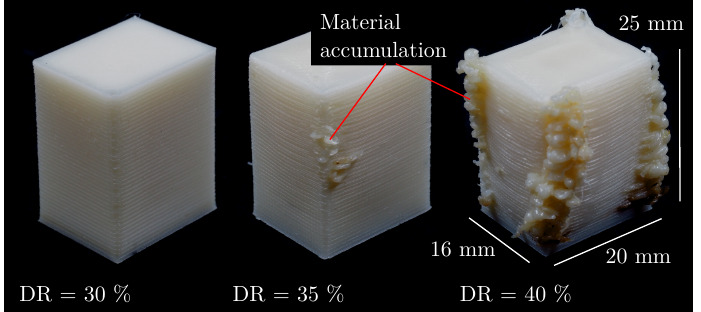
Figure 8. Three different specimens from the LT-DAR combination LT150DAR14. The DR is increased from the left to the right specimen and starting from a DR of 35% material accumulations are visible. The appearance of material accumulations is considered as the beginning of